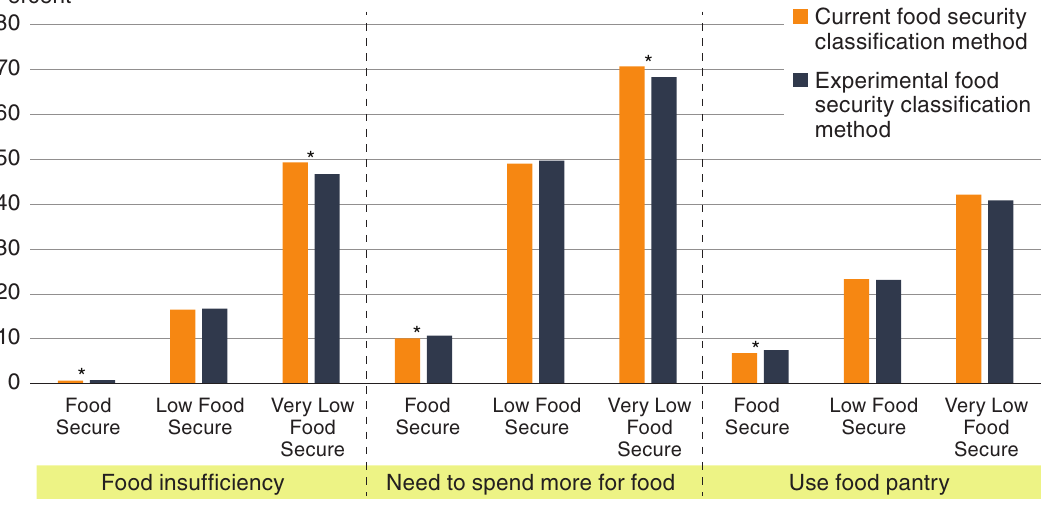
* Indicates difference between current and experimental classification is statistically significant (p < .10). Source: USDA, Economic Research Service using data from the Current Population Survey Food Security Supplement, 2008-15.